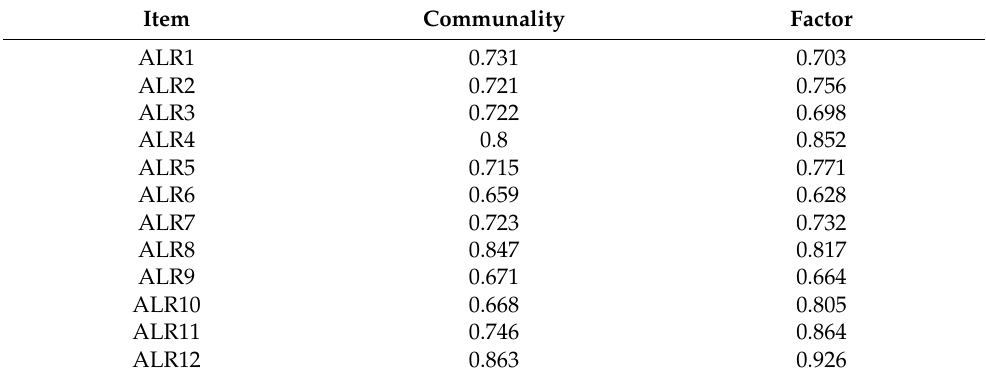
Table 2. Exploratory factor analysis.